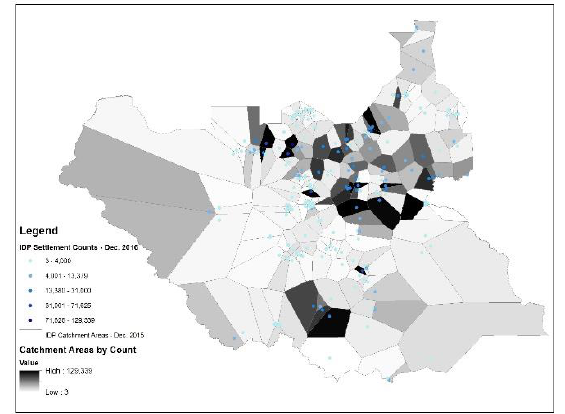
Figure 6. Population Proportions within Catchment Areas